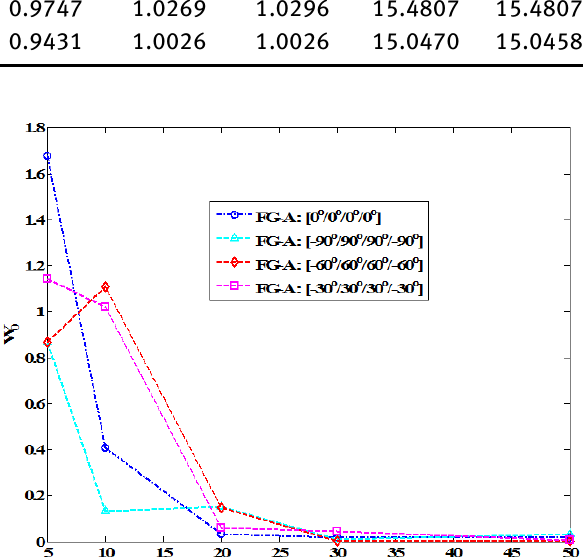
Figure 6: The non-dimensional deflection W o for angle–ply [- θ / θ / θ /- θ ] FG-V, SWCNT-FG plate with different lamination scheme form transverse load q 0 with volume fraction V CNT = 0.11